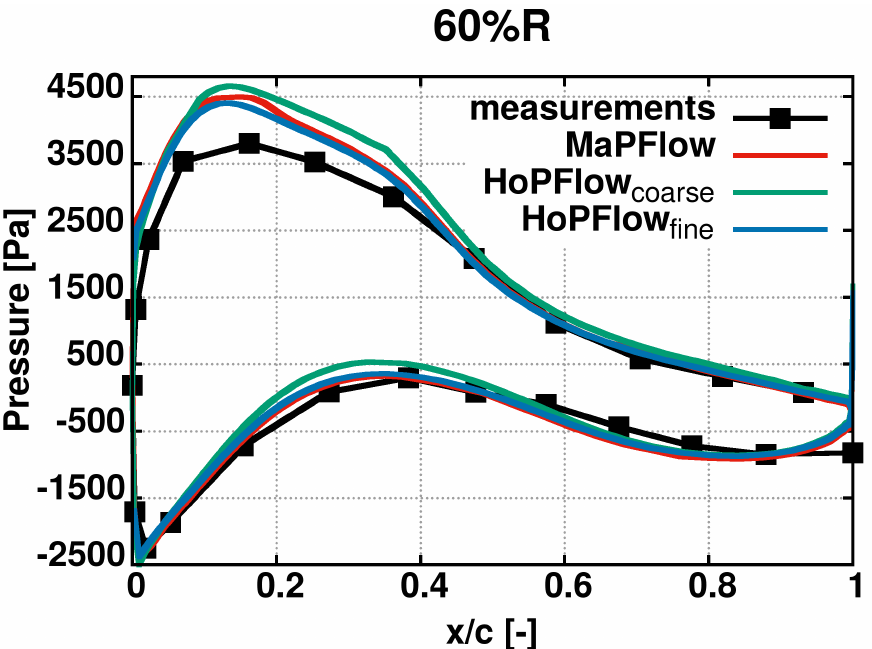
Figure 12. Pressure distribution at 60% of the blade. Comparison between experimental measure- ments and computational